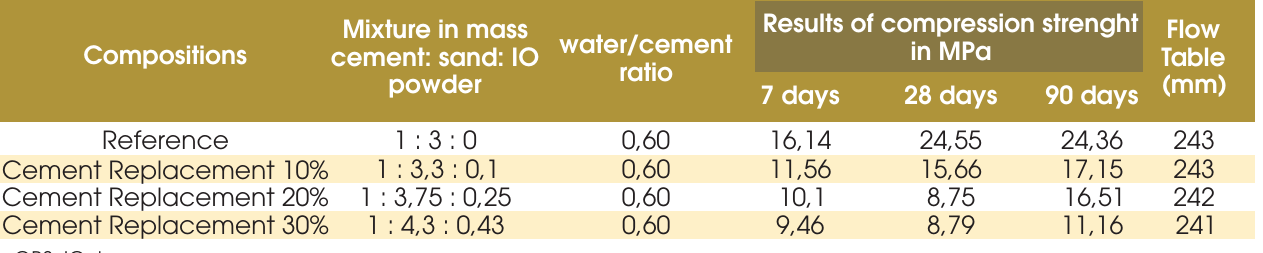
Table 3 – Compression strenght, w/c ratio and consistency index of cement replacement and reference